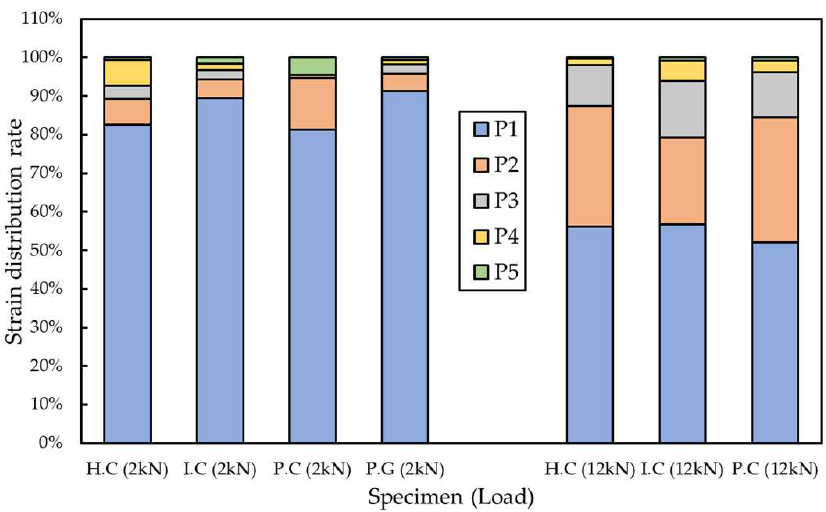
Figure 12. Load-bearing rate of grid points (2 kN, 12 kN of